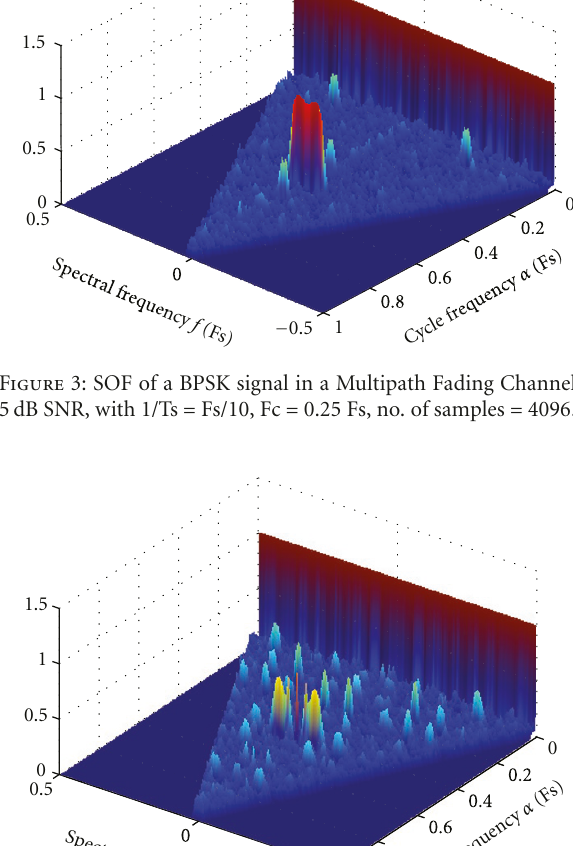
nullified by the channel. The SOFs of some typical signals undergoing multipath fading are shown in Figures 3 and